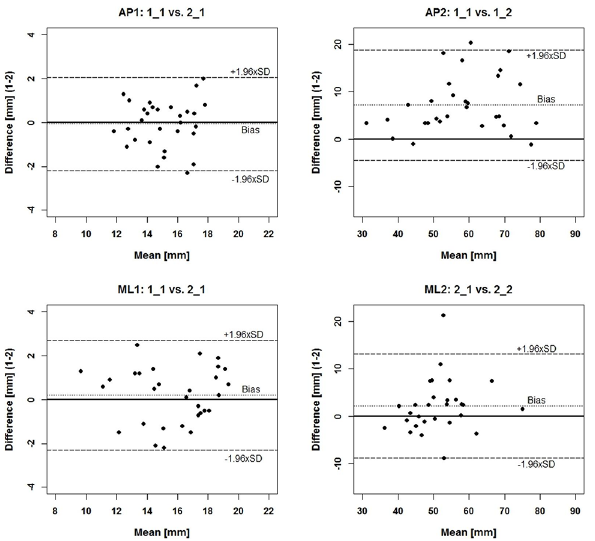
Fig 3. Bland-Altman plots for the AP (top) and ML (bottom) perturbation directions, showing examples for intervals 1 (left plots) and 2 (right